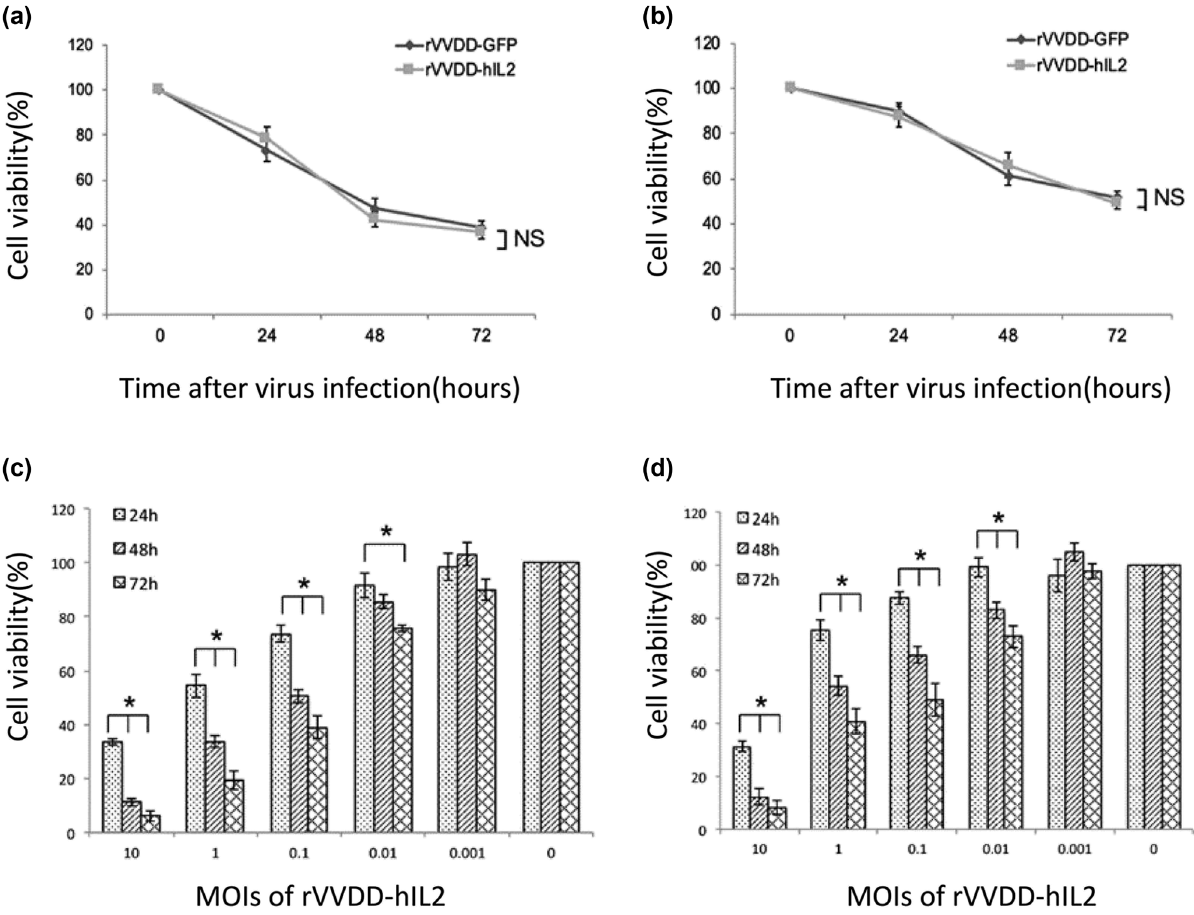
Figure 5: Oncolytic activities of rVVDD - hIL2 an rVVDD - GFP in tumor cell lines. Human lung carcinoma A549 ( a ) and murine colon tumor MC38 ( b ) cells were infected with rVVDD - hIL2 and rVVDD - GFP at an MOI of 0.1, respectively. Cell viability was determined by the MTS assay at the indicated time points ( rVVDD - hIL2 vs. rVVDD - GFP, P > 0.05, NS ) . ( c and d ) A549 and MC38 cells were infected with rVVDD - hIL2 at increasing doses ( MOIs of 0.001, 0.01, 0.1, 1, and 10 ) , and cell viability was measured by the MTS assay at the indicated times post - infection. * P < 0.05 compared to the cell viability at the time point of 24 h. Data were derived from three independent experiments. All comparisons were analyzed by the student ’ s t -